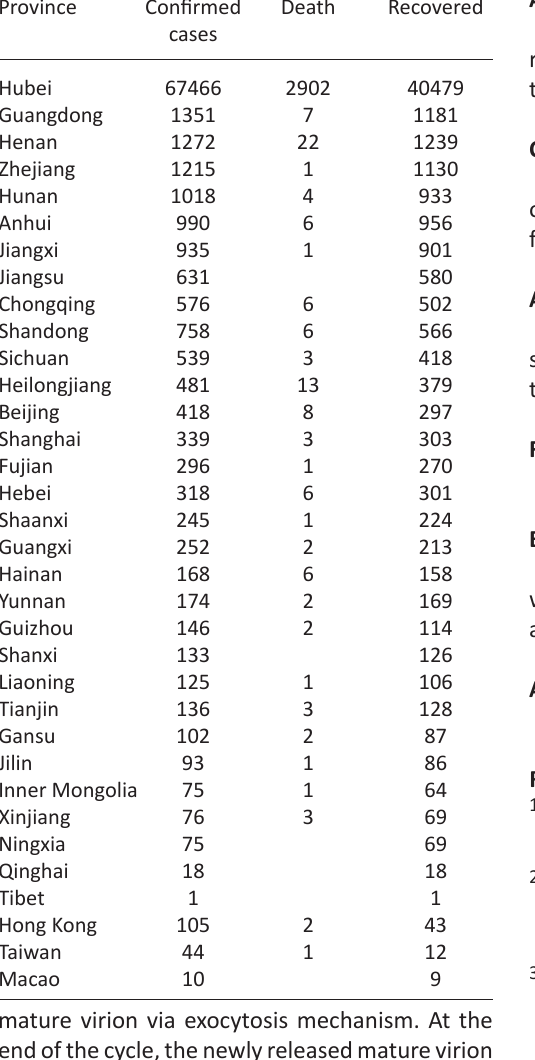
Table 1. Recent stats on the emergence and widespread distribution of novel-Coronavirus (2019-nCoV) in different provinces of CHINA. Data Source: IFENG News. Available online at the link:https://jobtube.cn/wv/? from= singlemessage &isapp installed=0 [Last